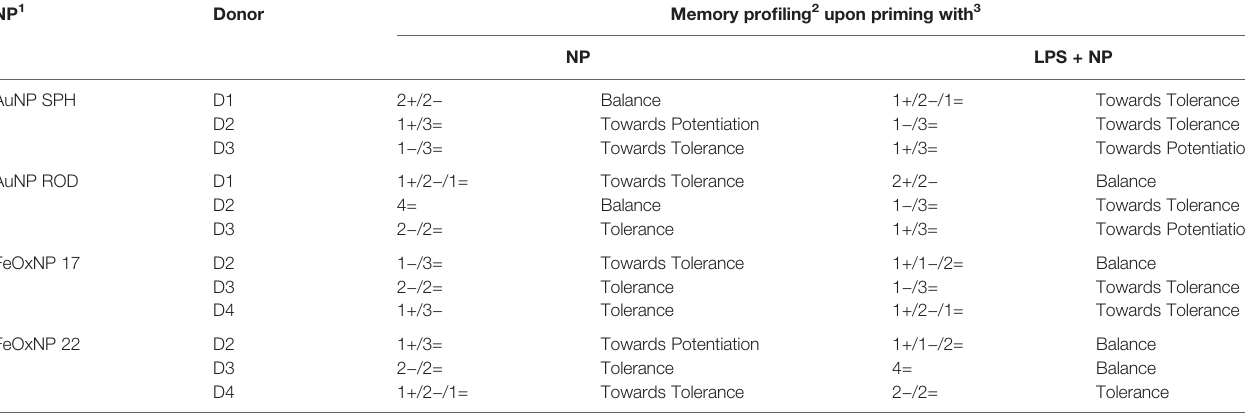
TABLE 4 | Individual pro fi ling of the NP-induced innate memory